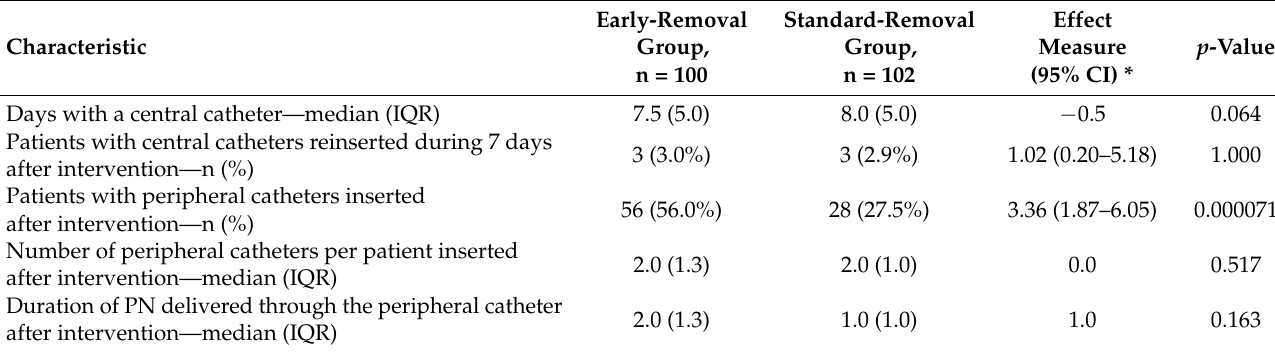
Table 5. Characteristics of parenteral